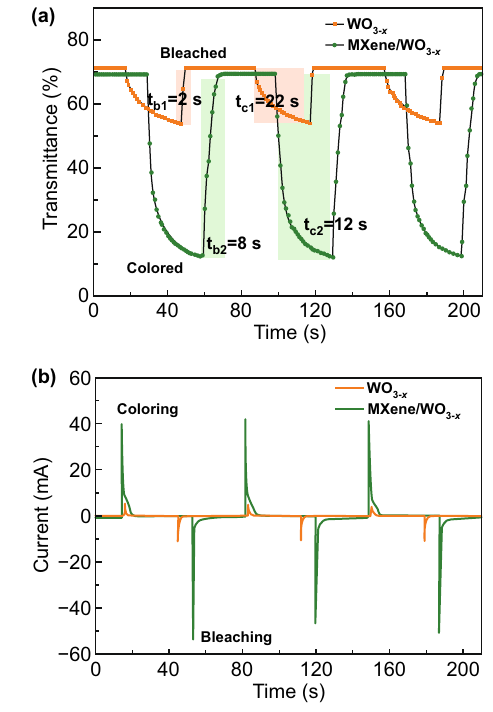
Fig. 4 a In-situ transmittance curves of the electrochromic devices based on pure WO 3− x and MXene/WO 3− x films at 660 nm. b Cor- responding chronoamperometry curves of the two electrochromic